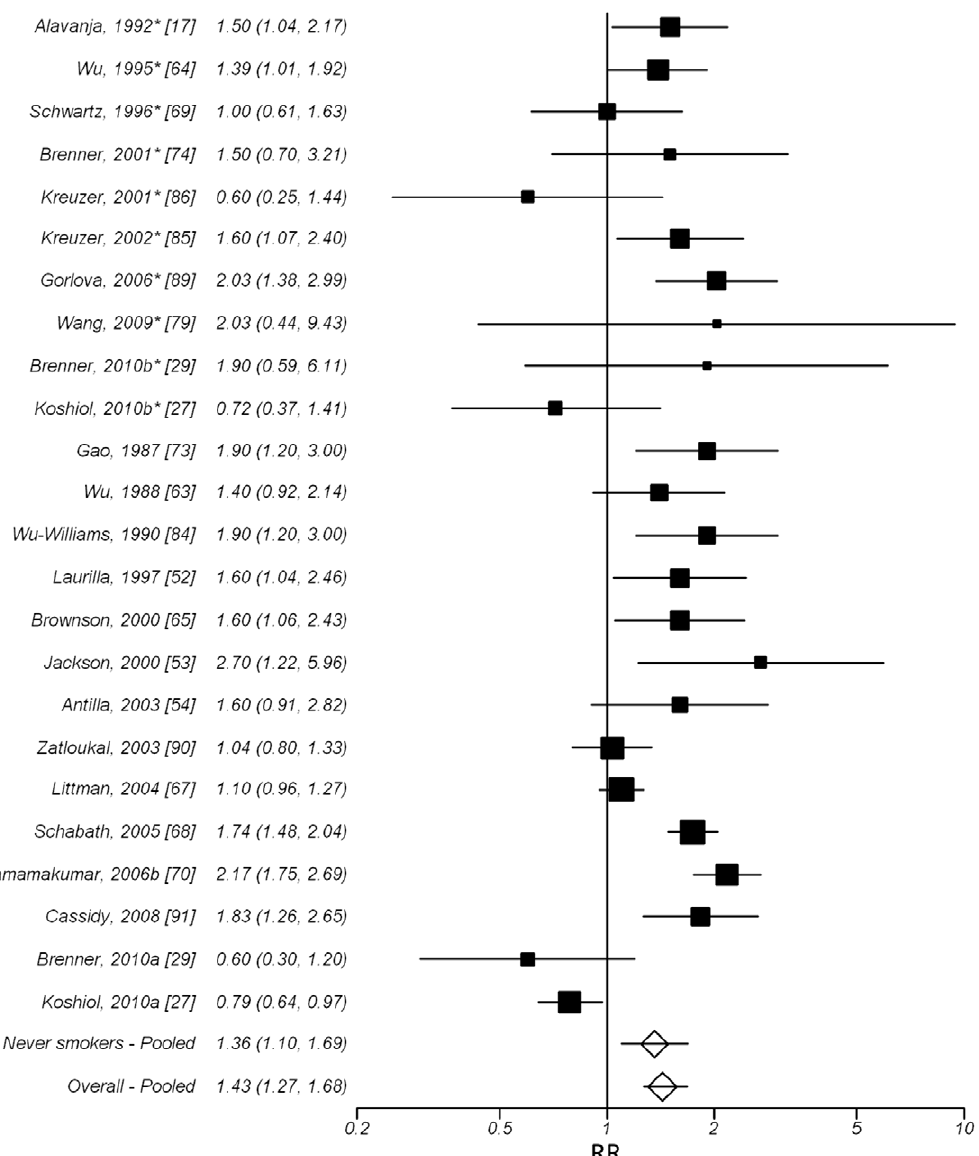
Figure 2. Pooled estimates of the risk associated with a previous diagnosis of pneumonia, separated by smoking status (never smokers on top, smokers on bottom) and overall. *Studies of never smokers. The pooled RRs were estimates from random effects models. The study labeled Ramanakumar, 2006b [70] represents the estimates for one population in study combined among males and females (no combined estimate originally provided). The studies noted with a b* represent the estimates from a subgroup of never smokers presented in the manuscript which were not included in the overall estimates.